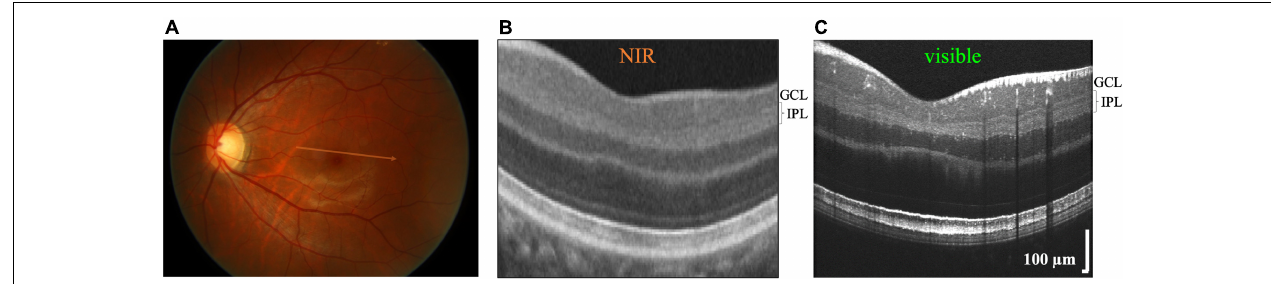
FIGURE 1 | Commercial near-infrared (NIR) and visible Optical Coherence Tomography (OCT) of a 26 years old Asian male with brown-colored iris. (A) OCT generates cross-sectional images by scanning broad bandwidth light on the fundus of the retina. Commercial NIR OCT (B) and visible light OCT (C) images of similar retinal eccentricities, intersecting the foveal pit superior to the foveola. Compared to commercial NIR OCT, visible light OCT achieves fivefold finer axial resolution, which improves visualization of substrata within the inner plexiform layer (IPL). In the visible light OCT image, IPL stratification is evident everywhere except near the central foveal pit. The NIR OCT image (B) was cropped from a Zeiss Cirrus High Definition 5 Line Raster scan (approximate location shown on fundus image in A